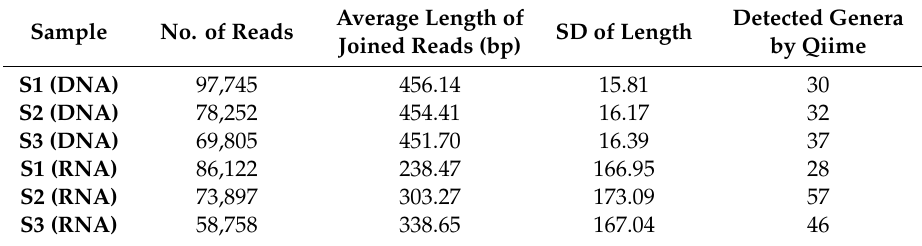
Table 1. Sequencing data after quality filtering and joining of forward and reverse reads, and